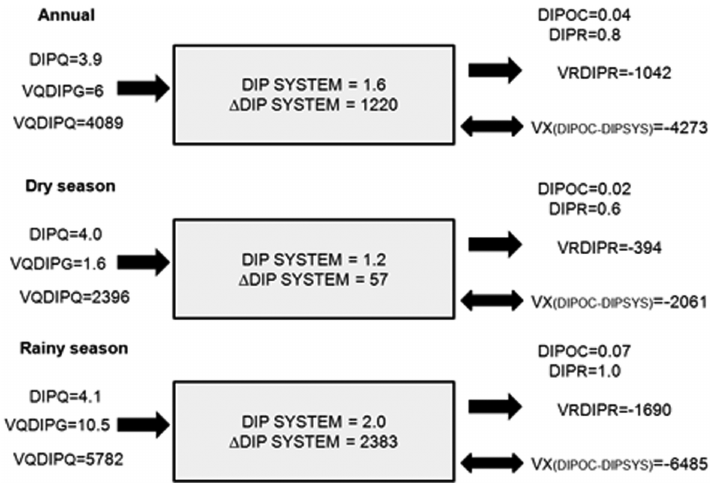
Fig. 4 – Annual and seasonal phosphorus flux (in moles d − 1 ) budget at the BJE. ( + ) indicates source, and ( − ) indicates